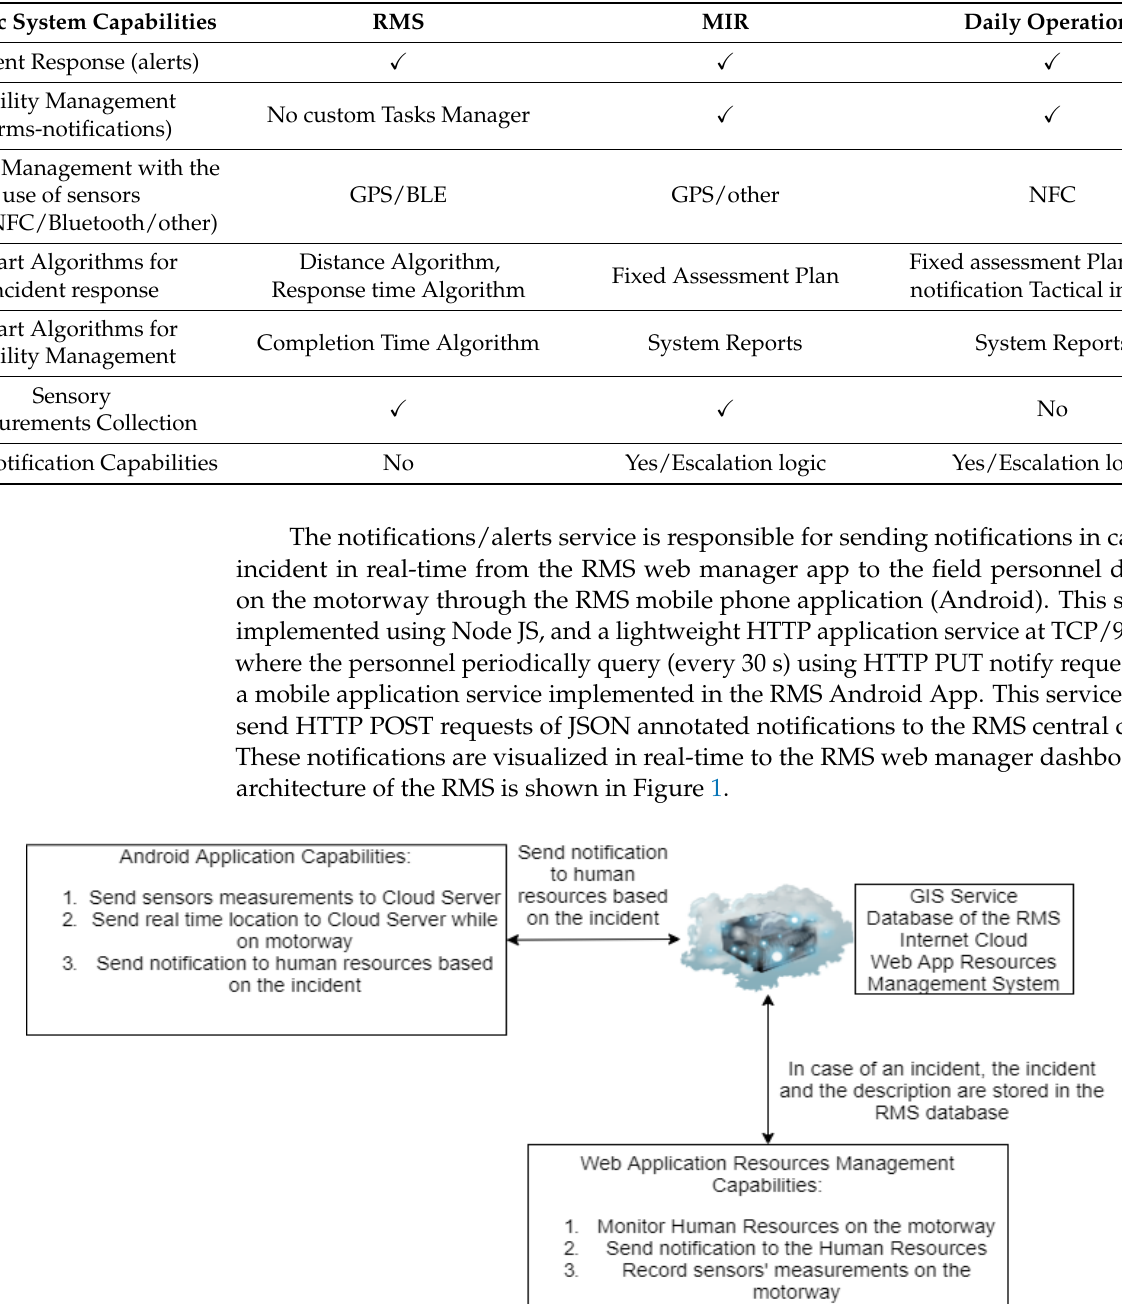
Table 1. RMS services functionality over existing facility management and incident response systems.